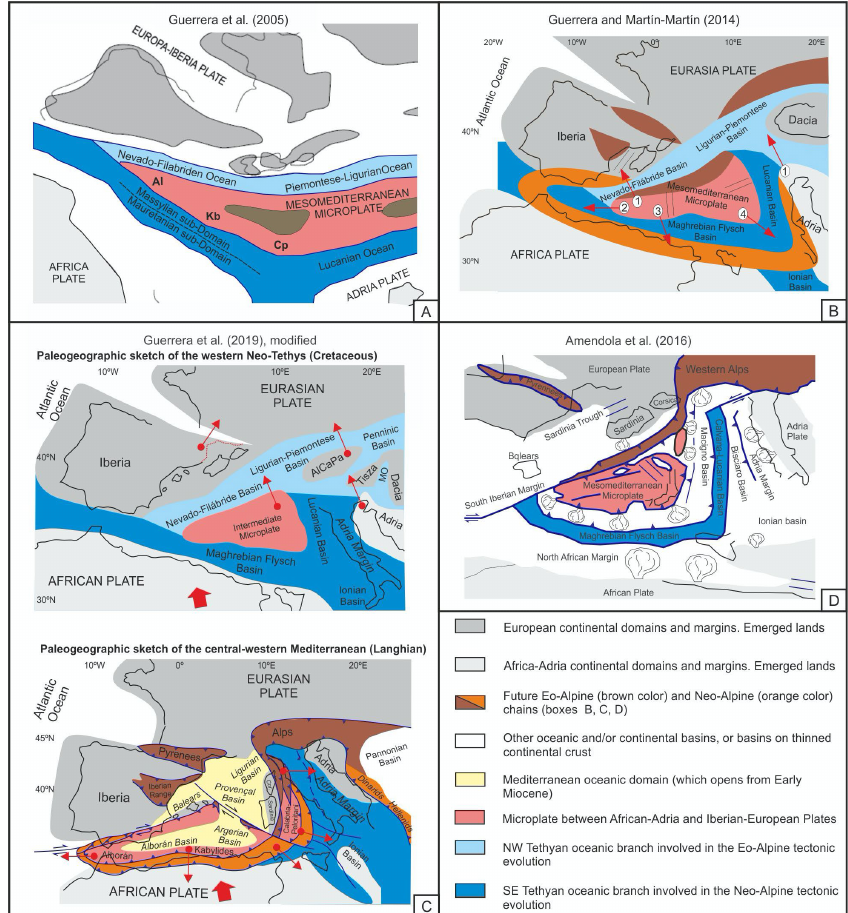
Figure 3. Redrawing of original figures showing the progressive improvements of paleogeographic and paleotectonic evolutionary models of the central-western Mediterranean region that consider the presence since Jurassic of two Tethyan oceanic branches separated by a microplate located between African and European Plates. Sketch maps showing the area in: ( A ), Cretaceous times (after [20], revised); ( B ), Cretaceous to Late Miocene (after [31], revised); ( C ), (two boxes), Cretaceous and Middle Miocene times (after [1], revised); ( D ), Early Miocene (after [32], revised). All reconstructions result from an interdisciplinary classical geology